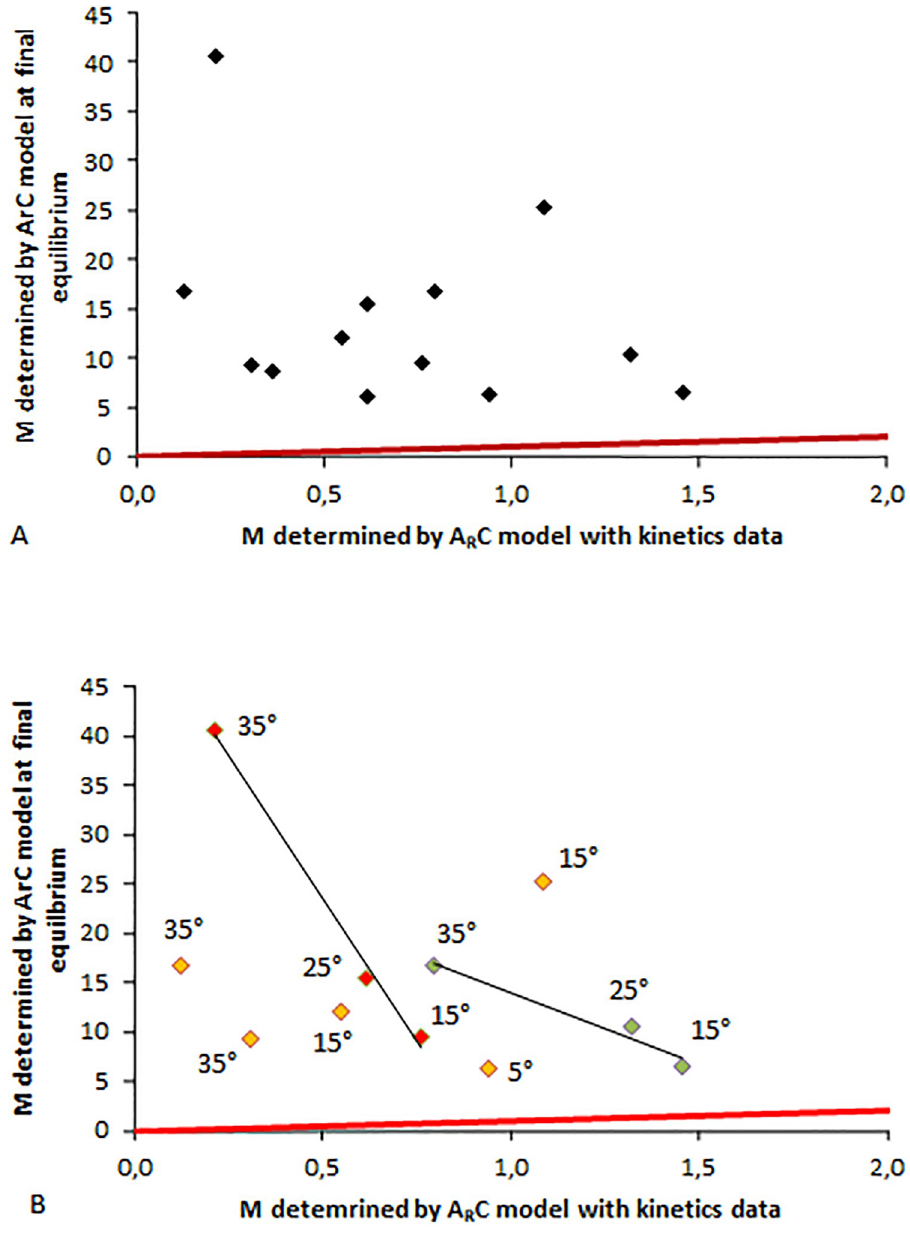
Fig 8. Relationship between M values of poplars computed from shapes at PGSA and M values computed from ArC model parameters given by linear regression. A: Whole dataset. B: Split dataset for the different light fluence rates. Green symbols: 15W neon tubes; Orange symbols: 40W neon tubes; Red symbols: 55W neon tubes. Initial tilting angle of the pot is indicated for each piece of data. Solid red line: line